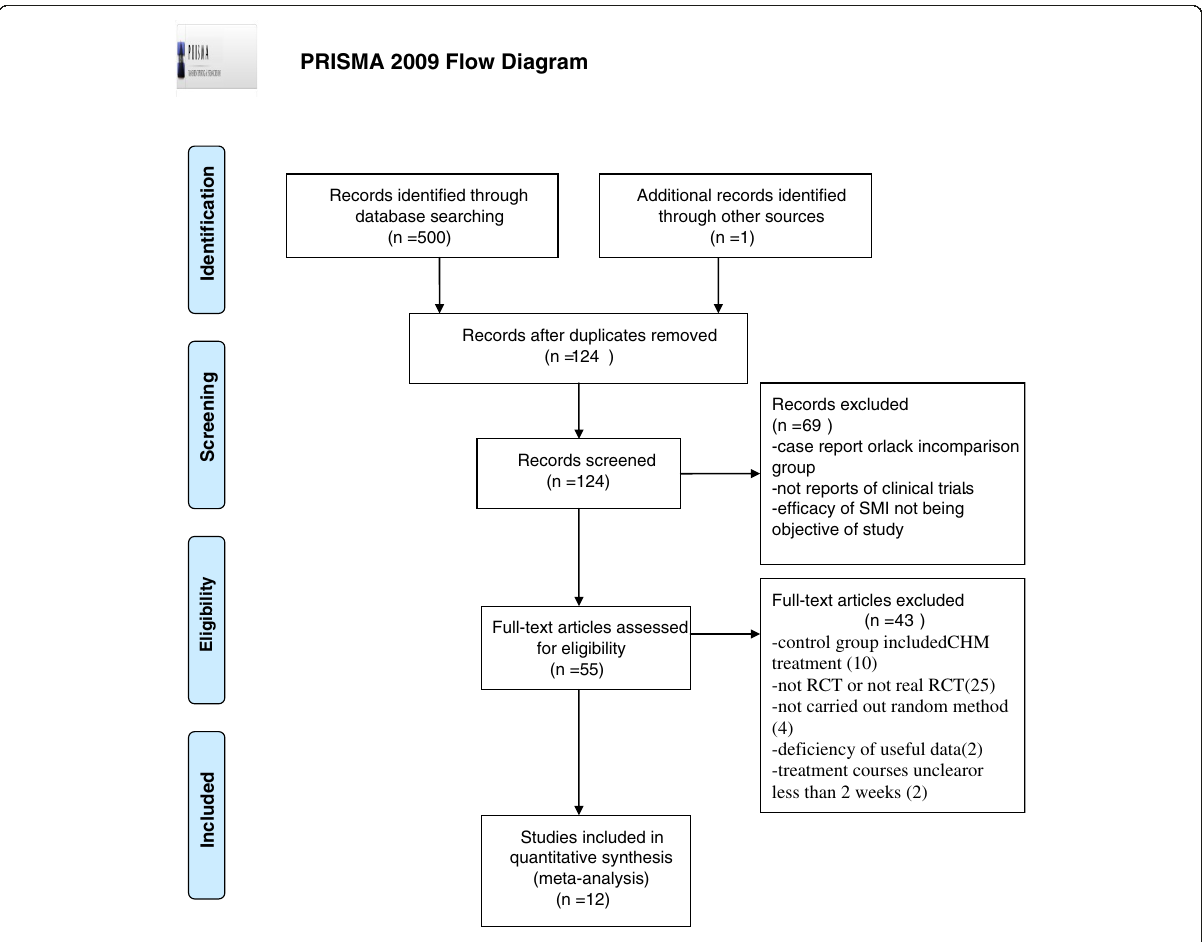
Figure 1 PRISMA 2009 Flow